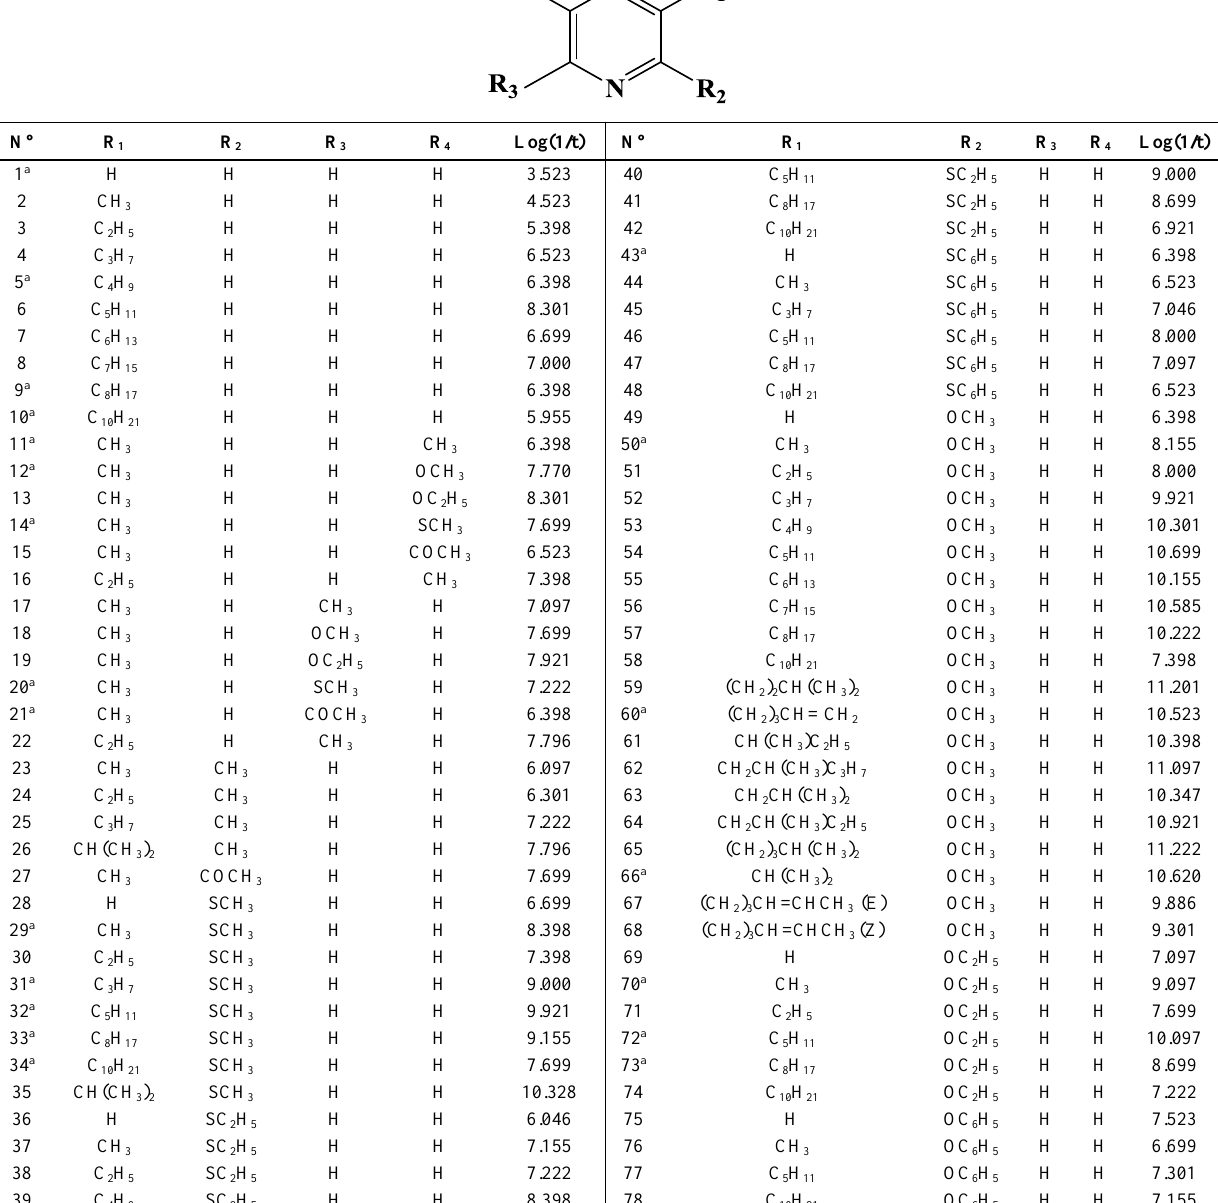
Table 1. Chemical structures of pyrazine derivatives used in this study and their experimental odors thresholds